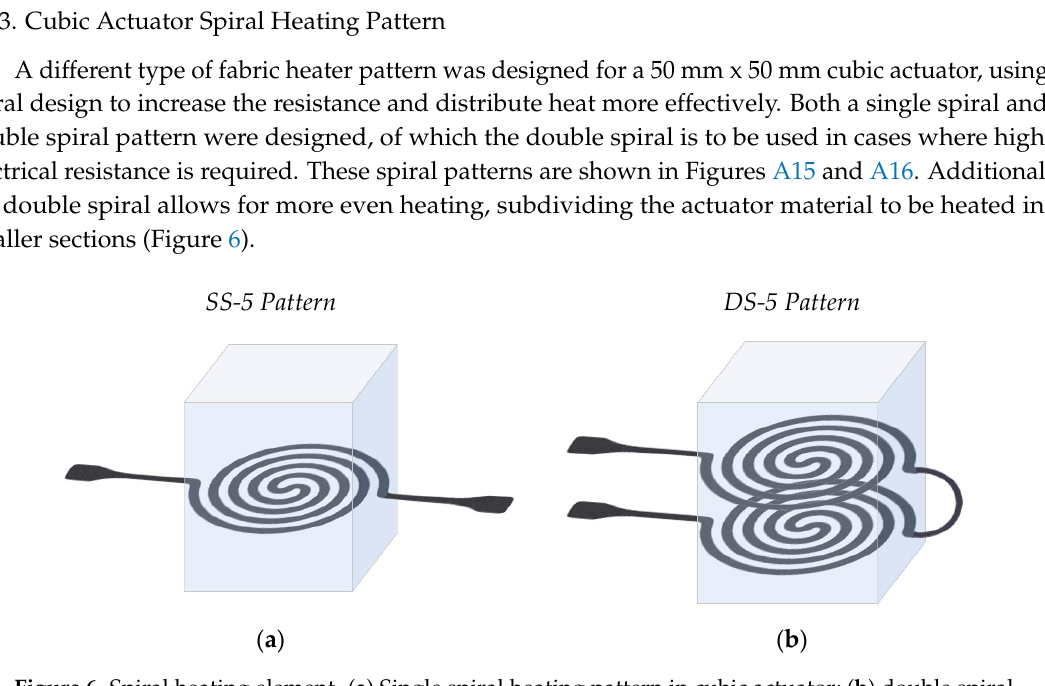
Figure 6. Spiral heating element. ( a ) Single spiral heating pattern in cubic actuator; ( b ) double spiral heating pattern in cubic actuator, layered evenly through the actuator. A small section in the middle of the double spiral is dedicated to allowing the material to bend into another section of the actuator.